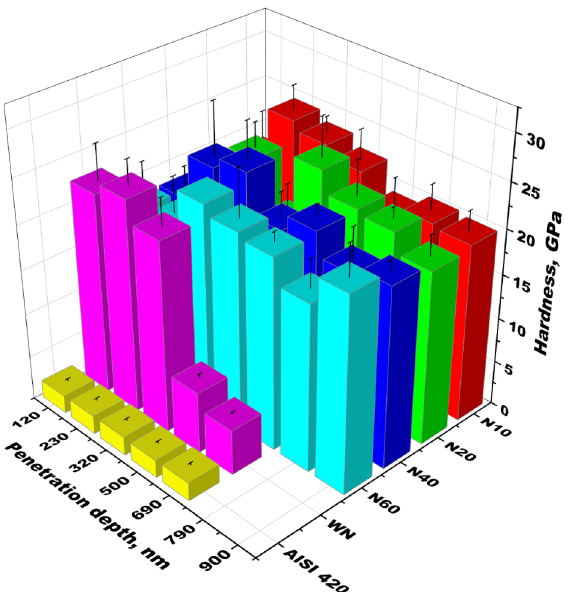
Figure 7. The dependences of the hardness of the samples on the penetration